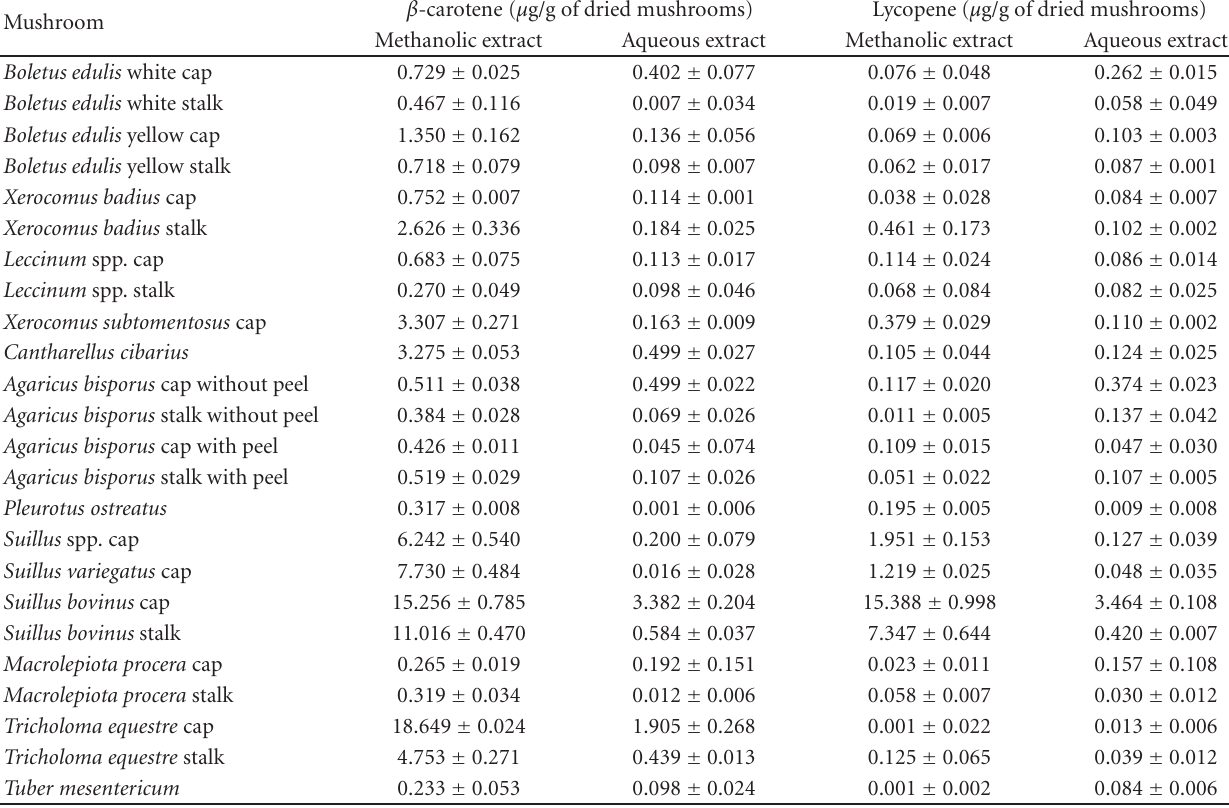
Table 2: The content of β -carotene and lycopene of edible Polish mushrooms ( μ g/g of dried